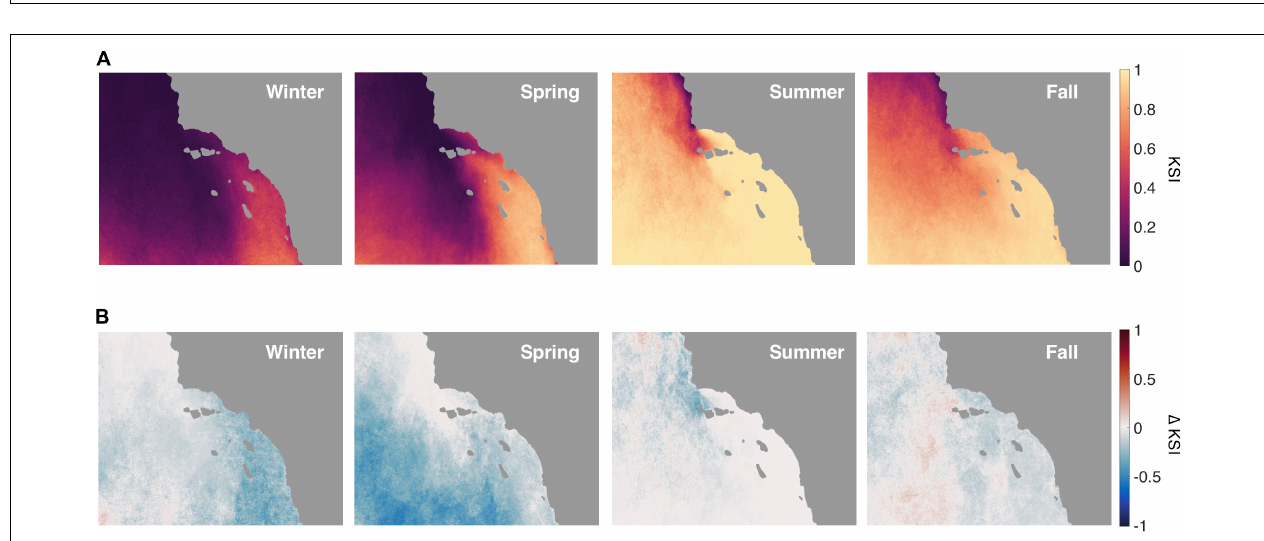
FIGURE 11 | Top row: Mean and coefficient of variation (CV) of estimated nitrate concentration over the study area across all seasons. Bottom row: Mean estimated nitrate concentration across each season over the study area. White contour line shows the location of the 1 µ mol L − 1 nitrate concentration front.